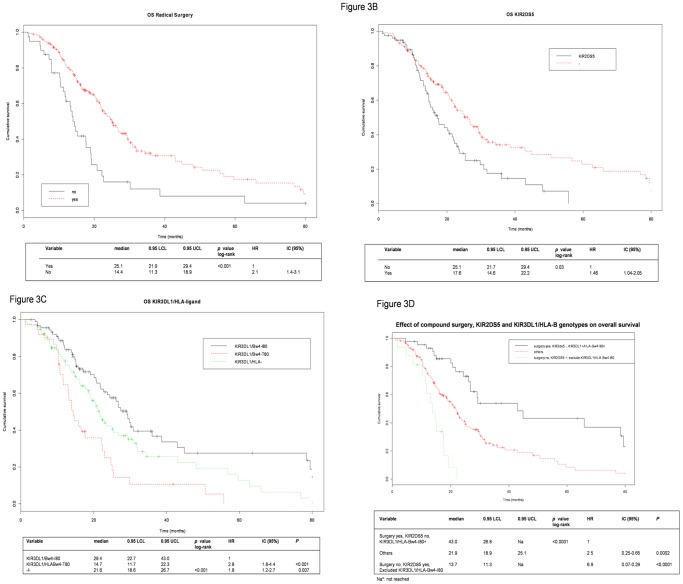
Kaplan-Meier survival curves (truncated at 80months) A) Kaplan-Meier plots of OS stratified by radical surgery Yes and No refer to presence or absence of radical surgery, respectively.
B) Kaplan-Meier plots of the association between KIR2DS5 and OS. OS curves of patients with KIR2DS5 (solid black line), or without the gene (−, red dashed line). The implication of this result could not be further investigated as the ligand of KIR2DS5 has not been identified yet. C) Kaplan-Meier plots of the association between KIR3DL1/HLA-B and OS. OS curves of patients with KIR3DL1/HLA-Bw4-I80 (solid black line), KIR3DL1/HLA-Bw4-T80 (dashed red line), or without either one (−/−, green dashed line). D) Kaplan-Meier plots of the association between a combination of surgery, KIR2DS5 and KIR3DL1/HLA and OS. Yes and No refer to presence or absence of radical surgery, respectively. − refers to the absence of the gene. Kaplan-Meier method, and log-rank were used to test the differences between subgroups. 0.95 LCL and 0.95 UCL; lower and upper 95th percentile, respectively; CI (95%); 95% confidence interval.